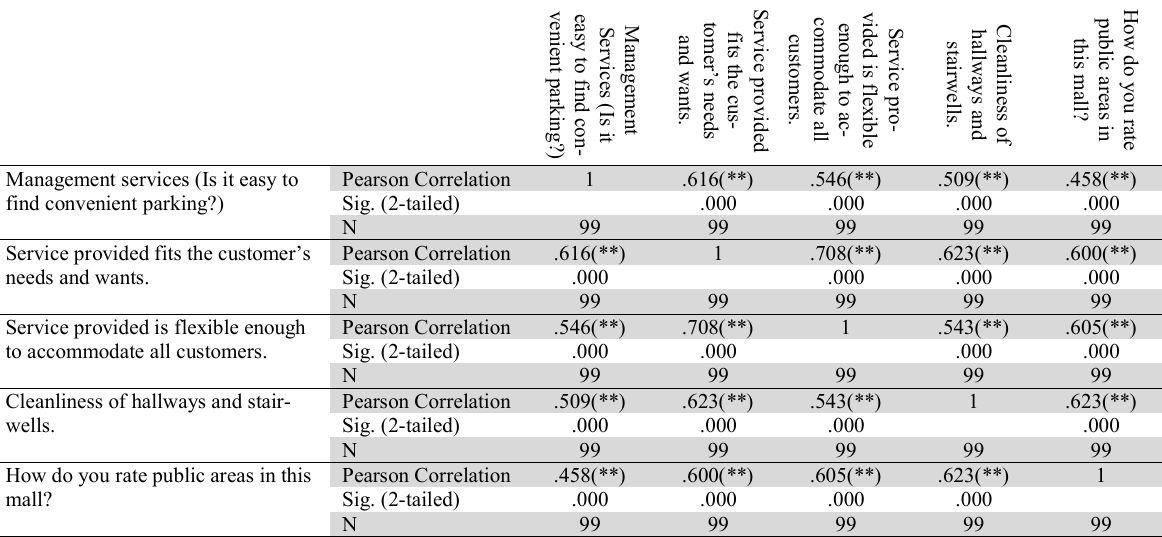
Correlation with Management